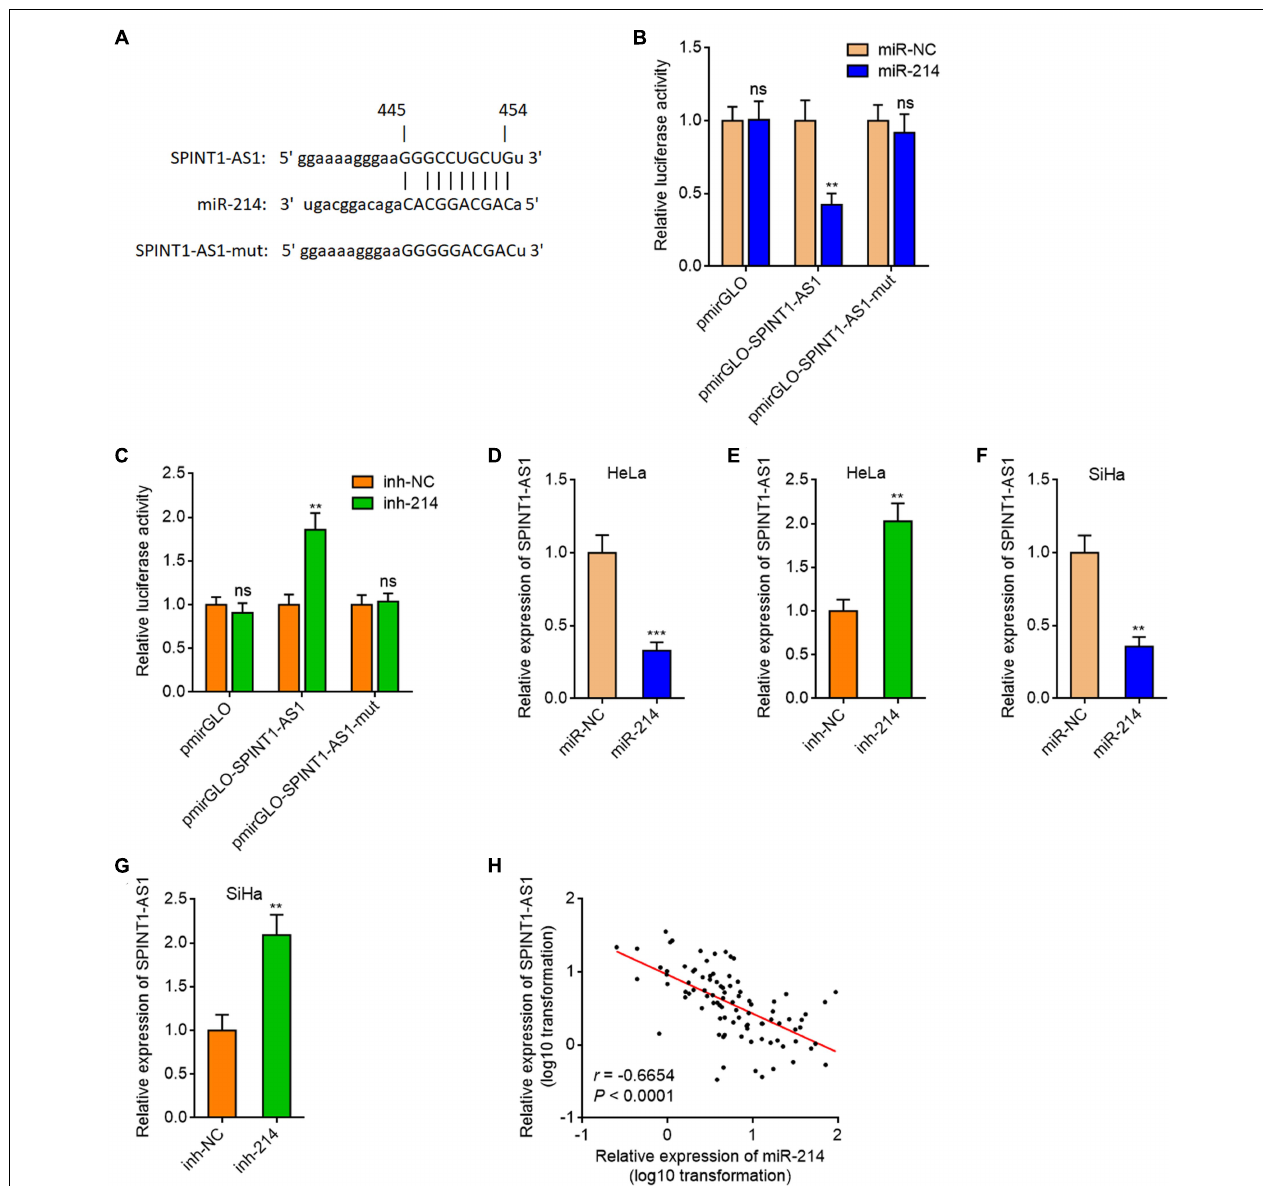
FIGURE 1 | SPINT1-AS1 was a target of miR-214 in cervical cancer. (A) Schematic diagram of the predicted miR-214 binding site on SPINT1-AS1. (B) Dual luciferase reporter assays in HeLa cells after co-transfection of luciferase reporter containing nothing, SPINT1-AS1, or mutated SPINT1-AS1 with miR-214 mimics or miRNA negative control (miR-NC). Data are shown as the relative ratio of firefly luciferase activity to renilla luciferase activity. (C) Dual luciferase reporter assays in HeLa cells after co-transfection of luciferase reporter containing nothing, SPINT1-AS1, or mutated SPINT1-AS1 with miR-214 inhibitors or inhibitor negative control (inh-NC). Data are shown as the relative ratio of firefly luciferase activity to renilla luciferase activity. (D) SPINT1-AS1 expression in HeLa cells after transfection of miR-214 mimics or miR-NC was detected by qRT-PCR. (E) SPINT1-AS1 expression in HeLa cells after transfection of miR-214 inhibitors or inh-NC was detected by qRT-PCR. (F) SPINT1-AS1 expression in SiHa cells after transfection of miR-214 mimics or miR-NC was detected by qRT-PCR. (G) SPINT1-AS1 expression in SiHa cells after transfection of miR-214 inhibitors or inh-NC was detected by qRT-PCR. For (B–G) , results are shown as mean ± SD based on three independent experiments. ** P < 0.01, *** P < 0.001, ns, not significant, by Student’s t -test. (H) The correlation between SPINT1-AS1 and miR-214 expression levels in 92 cervical cancer tissues. r = –0.6654, P < 0.0001 by non-parametric Spearman correlation analysis.